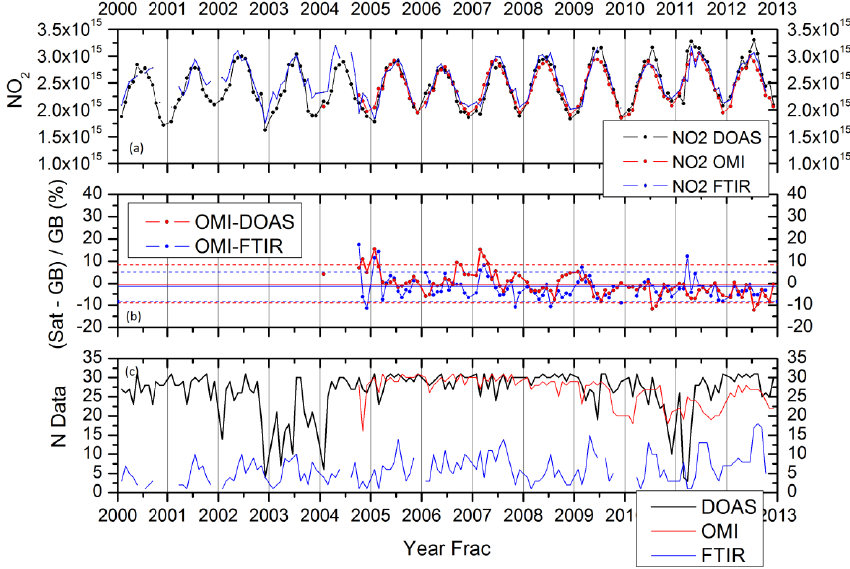
Figure 7. Same as Fig. 5 but for OMI vs. DOAS and FTIR (only a.m. data). Note that the scale in the top plot is different from Fig. 5.